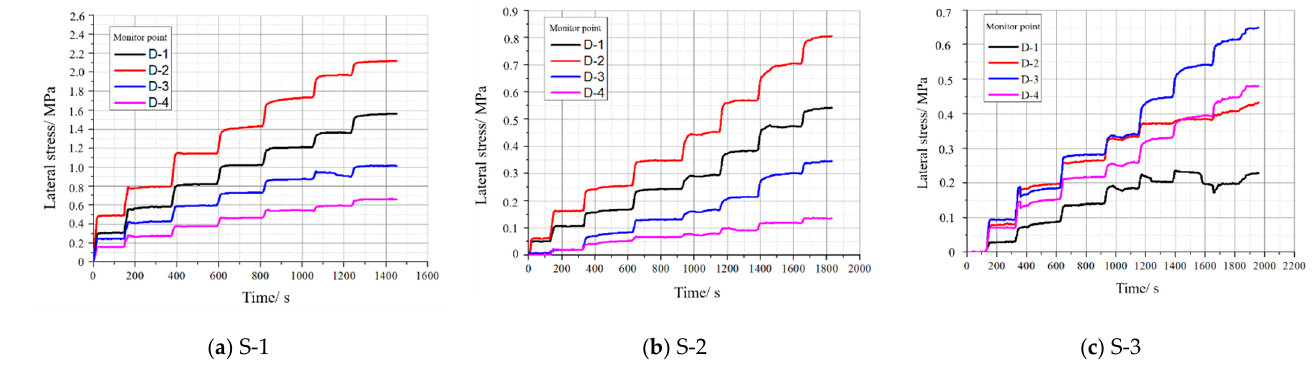
Figure 13. The lateral stress of the D column monitoring points.